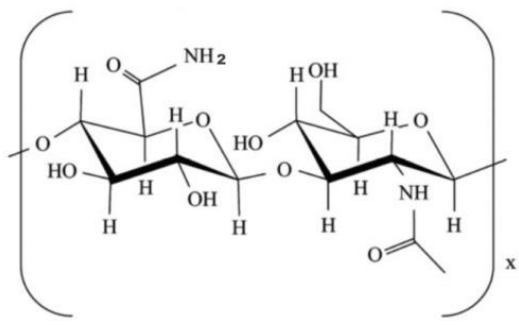
Figure 3. Structure unit of hyaluronic acid (HA).